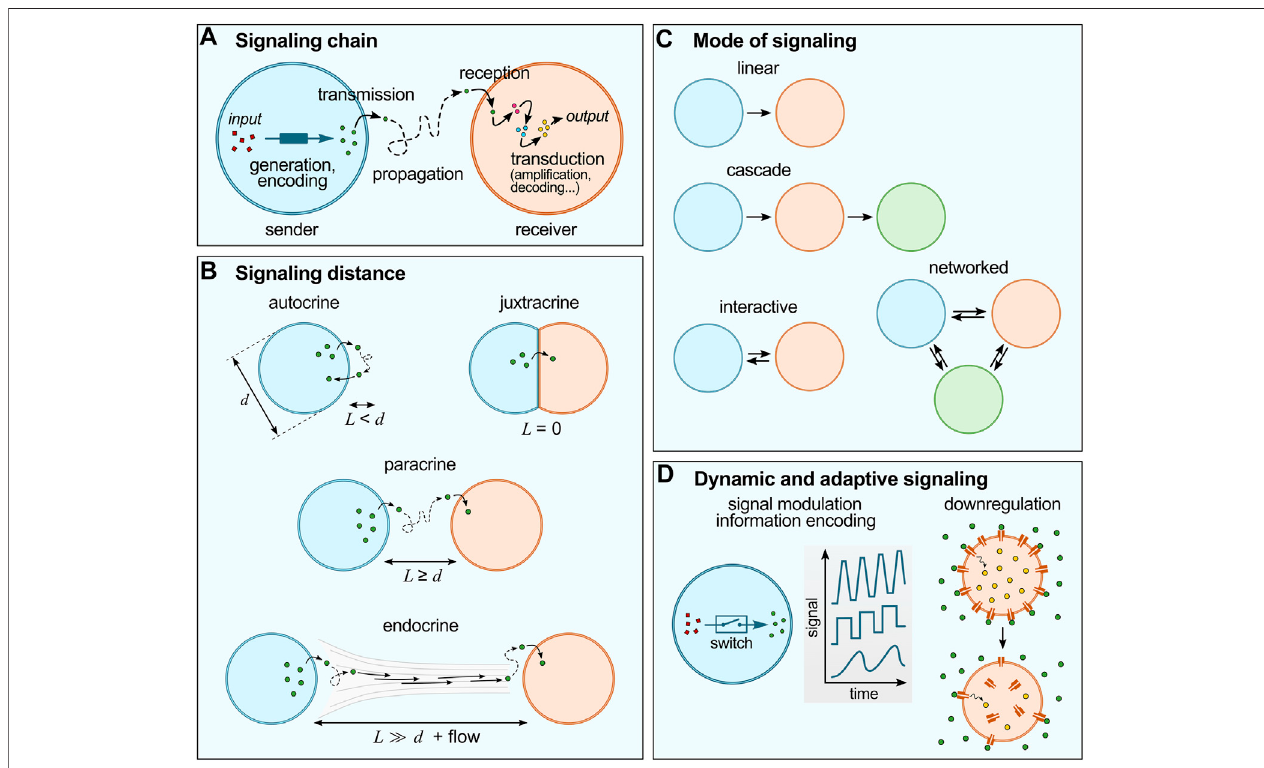
FIGURE 1 | Basic concepts of cell chemical signaling. (A) The signaling chain include a sender and a receiver cell, a signal (generated and encoded in the sender cell; and transduced within the receiver cell) and a propagation medium. (B) Chemical signaling can be characterized by the distance between sender and receiver cells ( L ) compared to the typical size of the cells ( d ). (C) Different modes of signaling are possible, from simple linear or cascade modes to more sophisticated interactive of networkedmodes. (D) Cellsignalingisdynamicandadaptive: forinstance,livingcellsutilizeswitchestoregulatesignalproduction(concentration,frequency,etc.), and advanced recon fi gurable systems to regulate signal responses, such as receptor